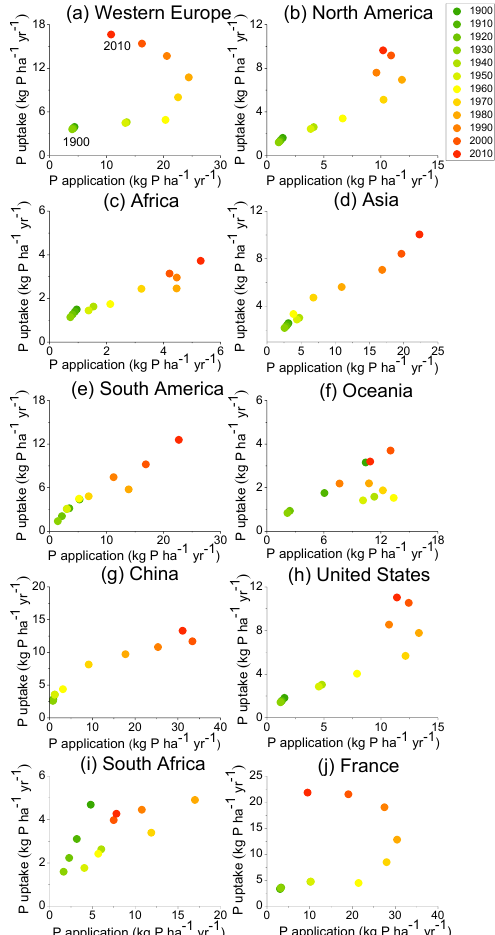
Figure 4. P uptake vs. P application between 1900 and 2010. The contribution of residual P to P uptake can be observed in western Europe (a) and France (j) as P uptake has steadily increased with time, yet P application has decreased since the